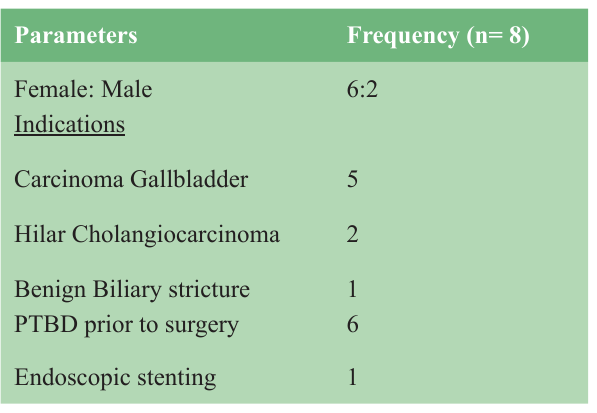
Table 1. Patient’s demographics